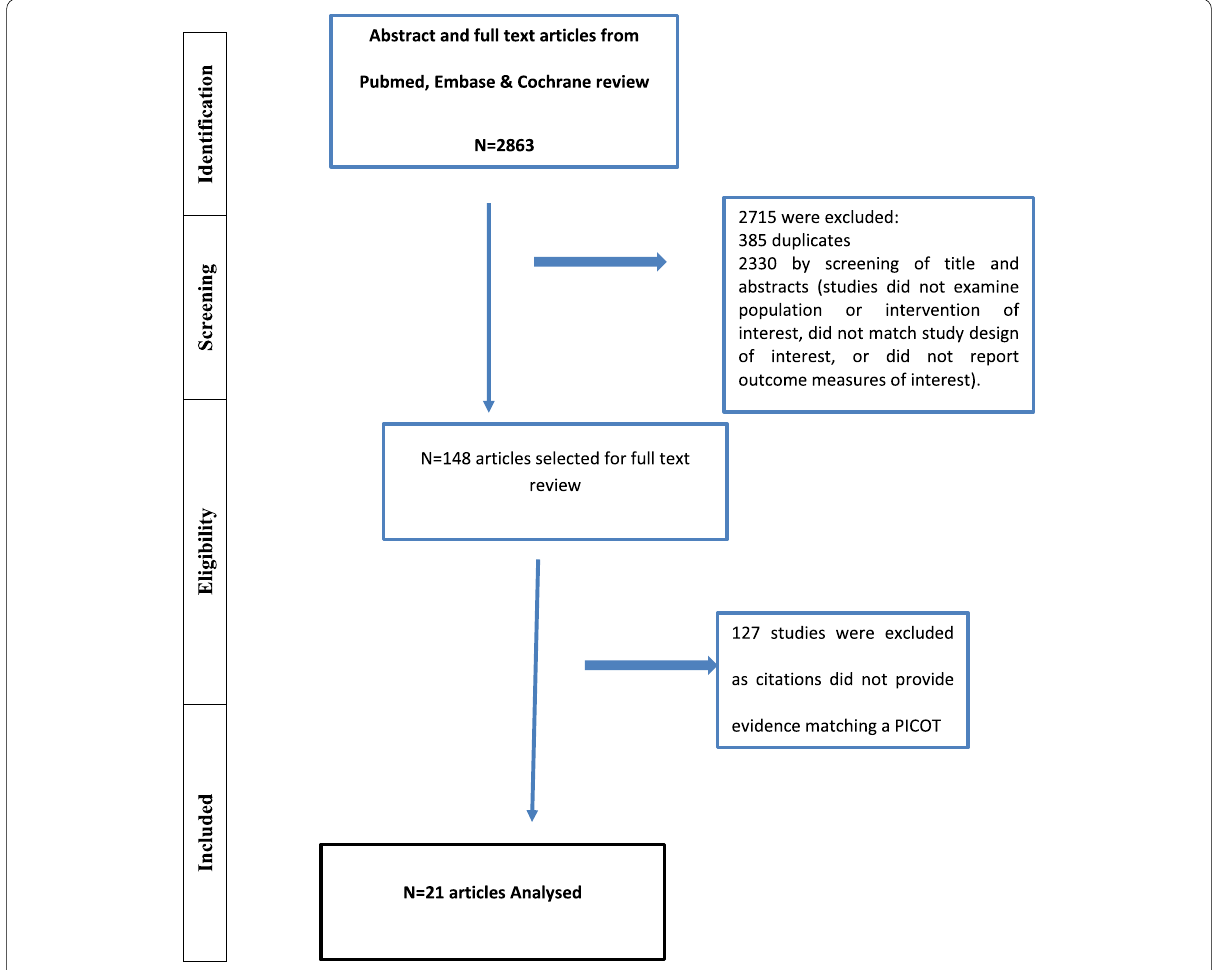
Fig. 1 Flow chart for the study selection